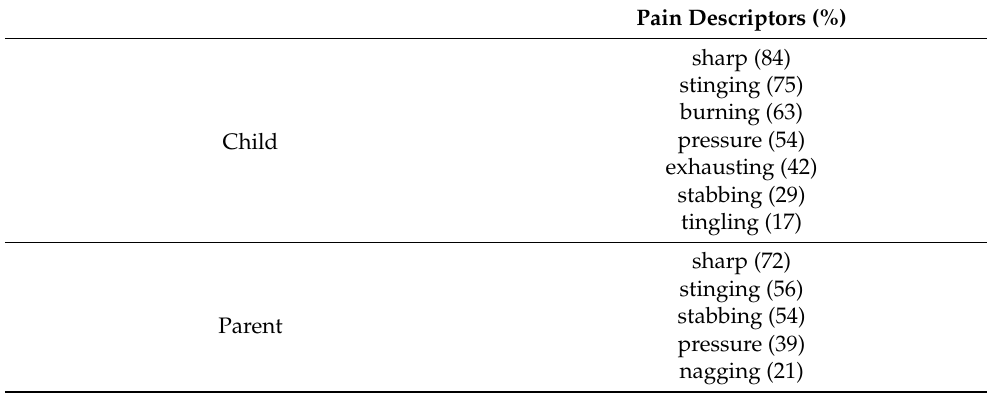
Table 6. Pain descriptors (in percentages) by children with TS and their